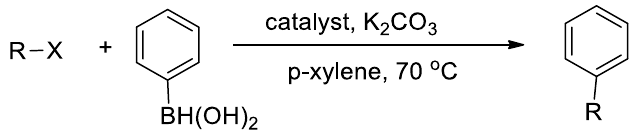
Figure 14. Recycle test of 3D COF (3D-HNU5) for CO 2 capture.